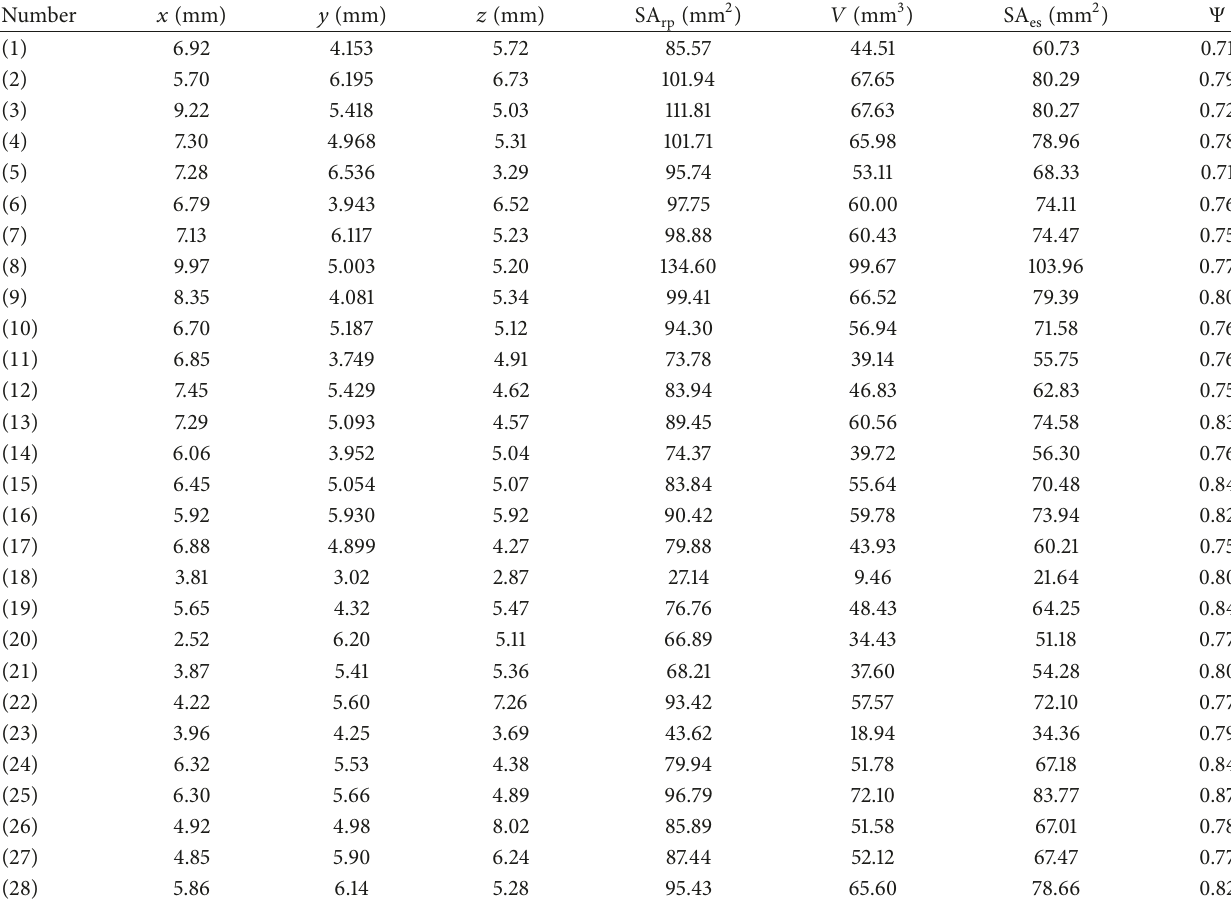
Table 3: The real physical properties of twenty-eight